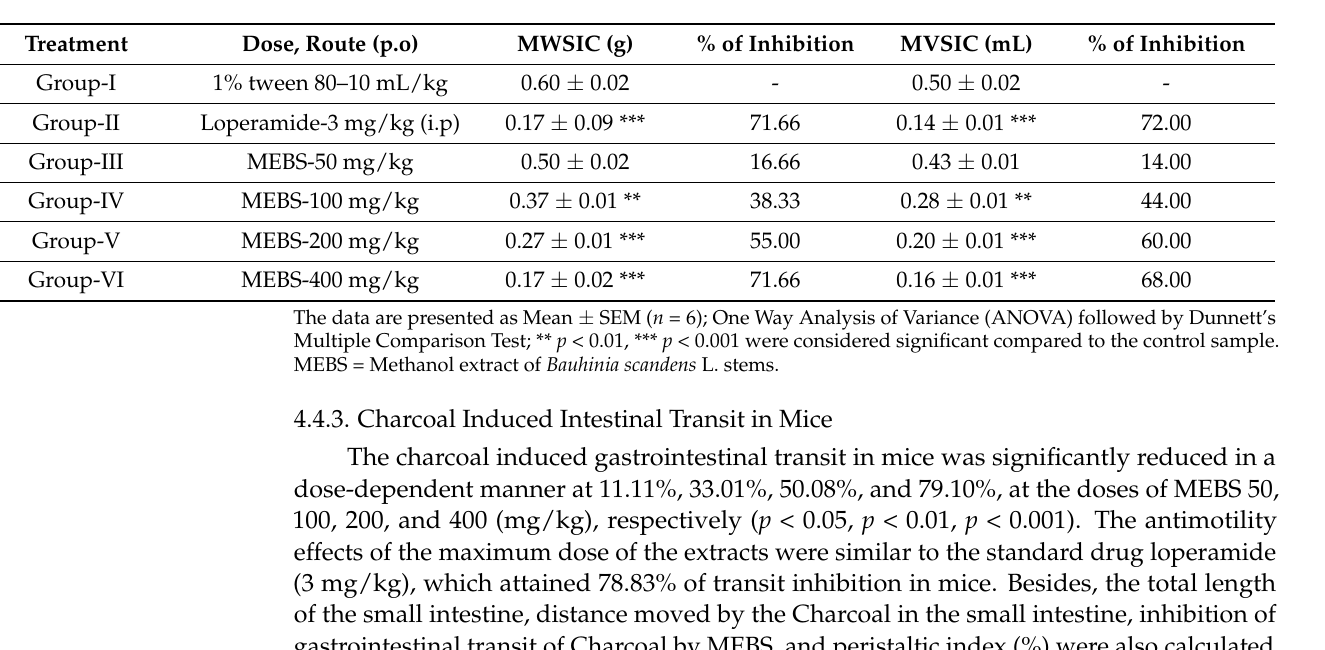
Table 3. Impact of the test samples on castor oil incited intraluminal fluid accumulation in mice.